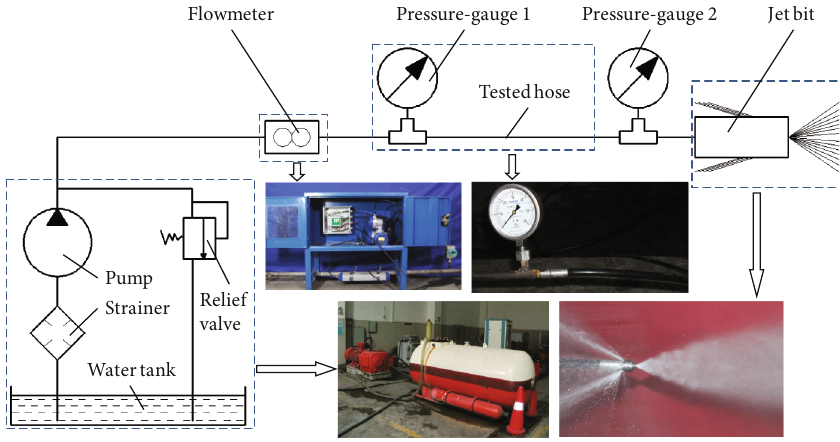
Figure 2: Schematic of the test